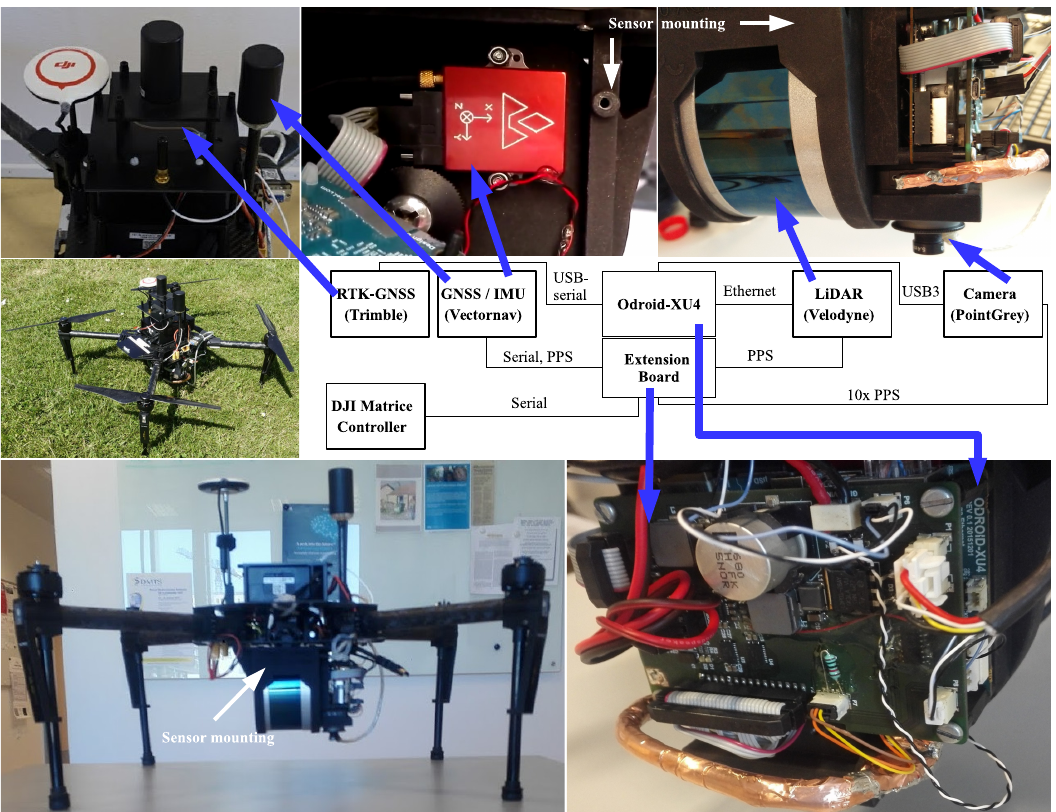
Figure 3. Sensor mounting added to the DJI Matrice 100 platform [32]. The block diagram shows how the sensors are connected to the Odroid XU4 (Hardkernel co., Ltd., GyeongGi, South Korea). The camera and LiDAR are facing downwards to observe the crops and